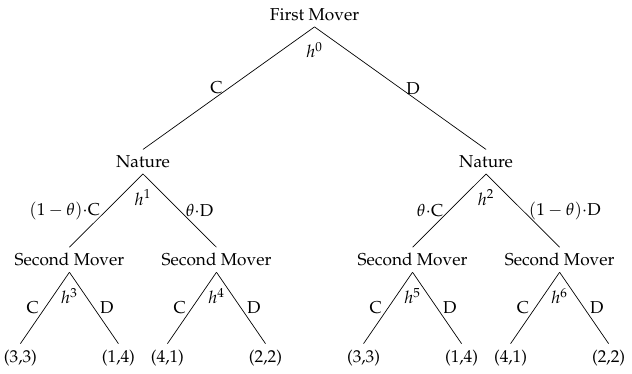
Figure 1. Sequential Prisoner’s Dilemma with Nature and Perfect Information.